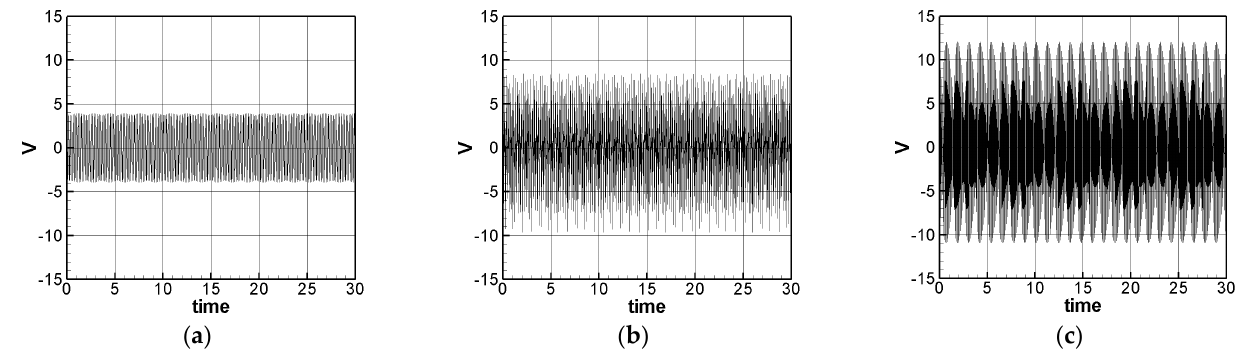
Figure 20. DES system theoretical voltage output (with dimension (volt)). ( a ) 1st mode, ( b ) 2nd mode, and ( c ) 3rd mode.